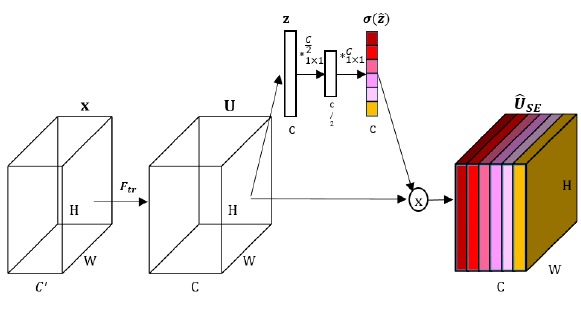
Figure 2. Squeeze & Excitation (SE)